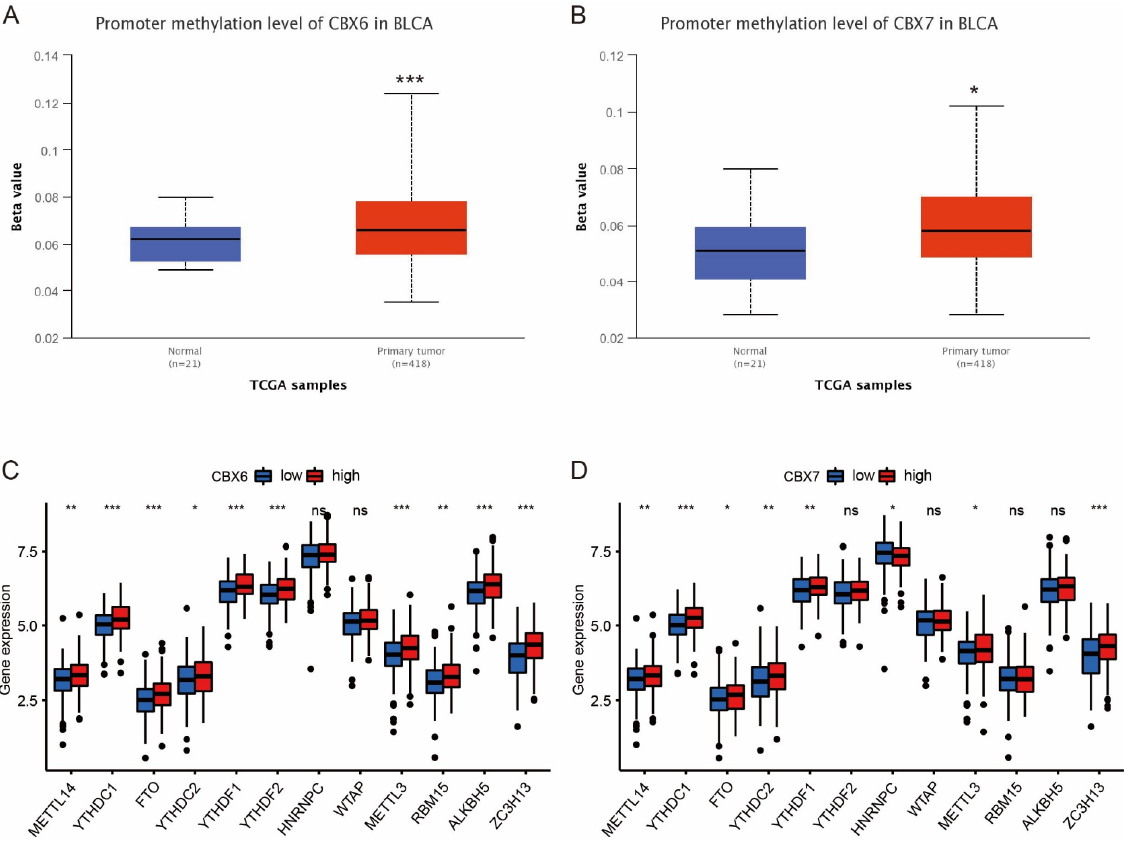
Figure 7. Association of CBX6 and CBX7 with m6A-related gene. ( A ) Promoter methylation levels of CBX6 in normal and bladder cancer tissues. ( B ) Promoter methylation levels of CBX7 in normal and bladder cancer tissues. ( C ) Variations in m6A-related gene expression between groups with high and low CBX6 expression. ( D ) Differences in the expression of m6A-related genes between groups with high and low CBX7 expression. * p < 0.05; ** p < 0.01; *** p < 0.001; ns, not significant.